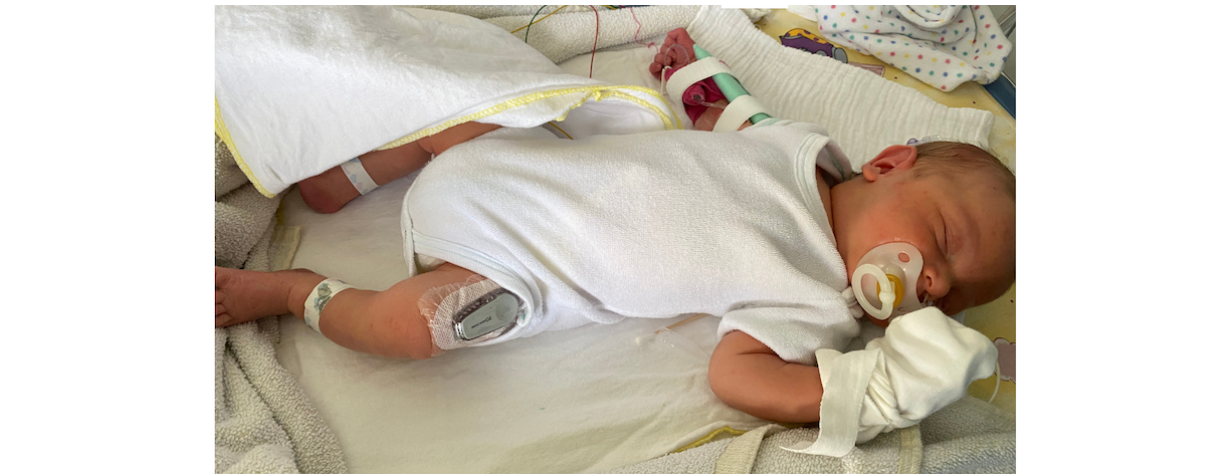
Figure 1. Upper thigh as a suitable rtCGM application site in neonates.